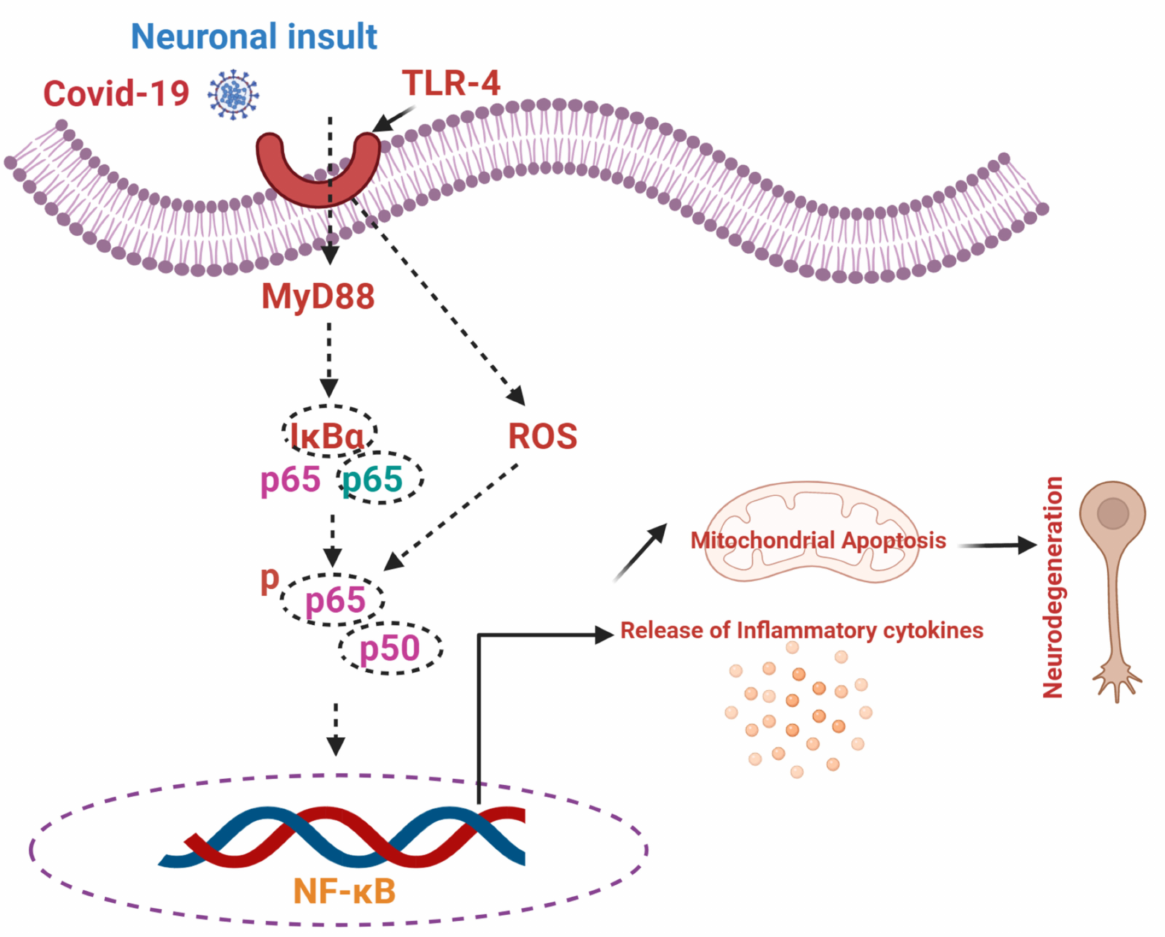
Figure 3. Role of TLR4 and NF- κ B in the execution of inflammation, apoptotic cell death, and neurodegeneration. ROS: reactive oxygen species; TLR-4: toll-like receptor-4; ROS: reactive oxygen species; NF- κ B: nuclear factor kappa